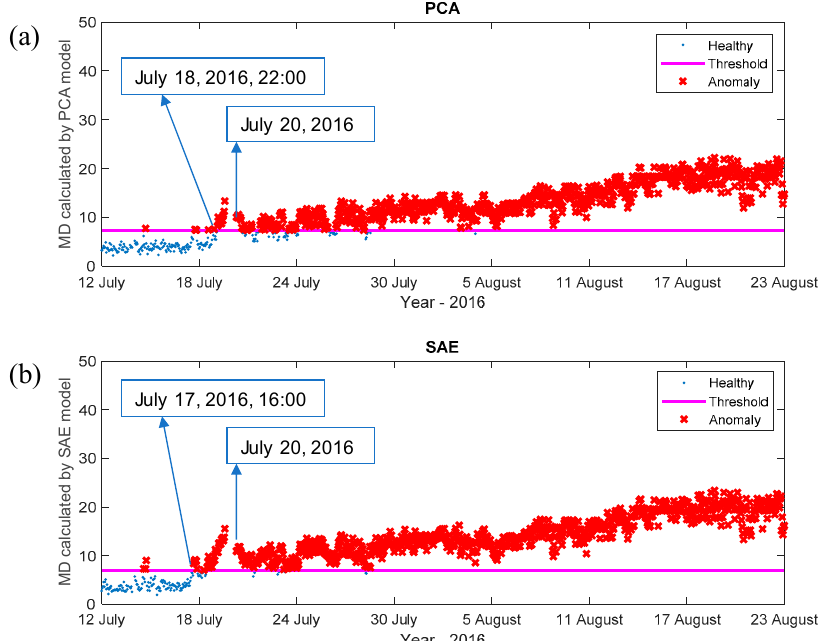
Figure 11. Anomaly detection from 12 July 2016 to 23 August 2016. ( a ) Anomaly detection by PCA. ( b ) Anomaly detection by SAE.